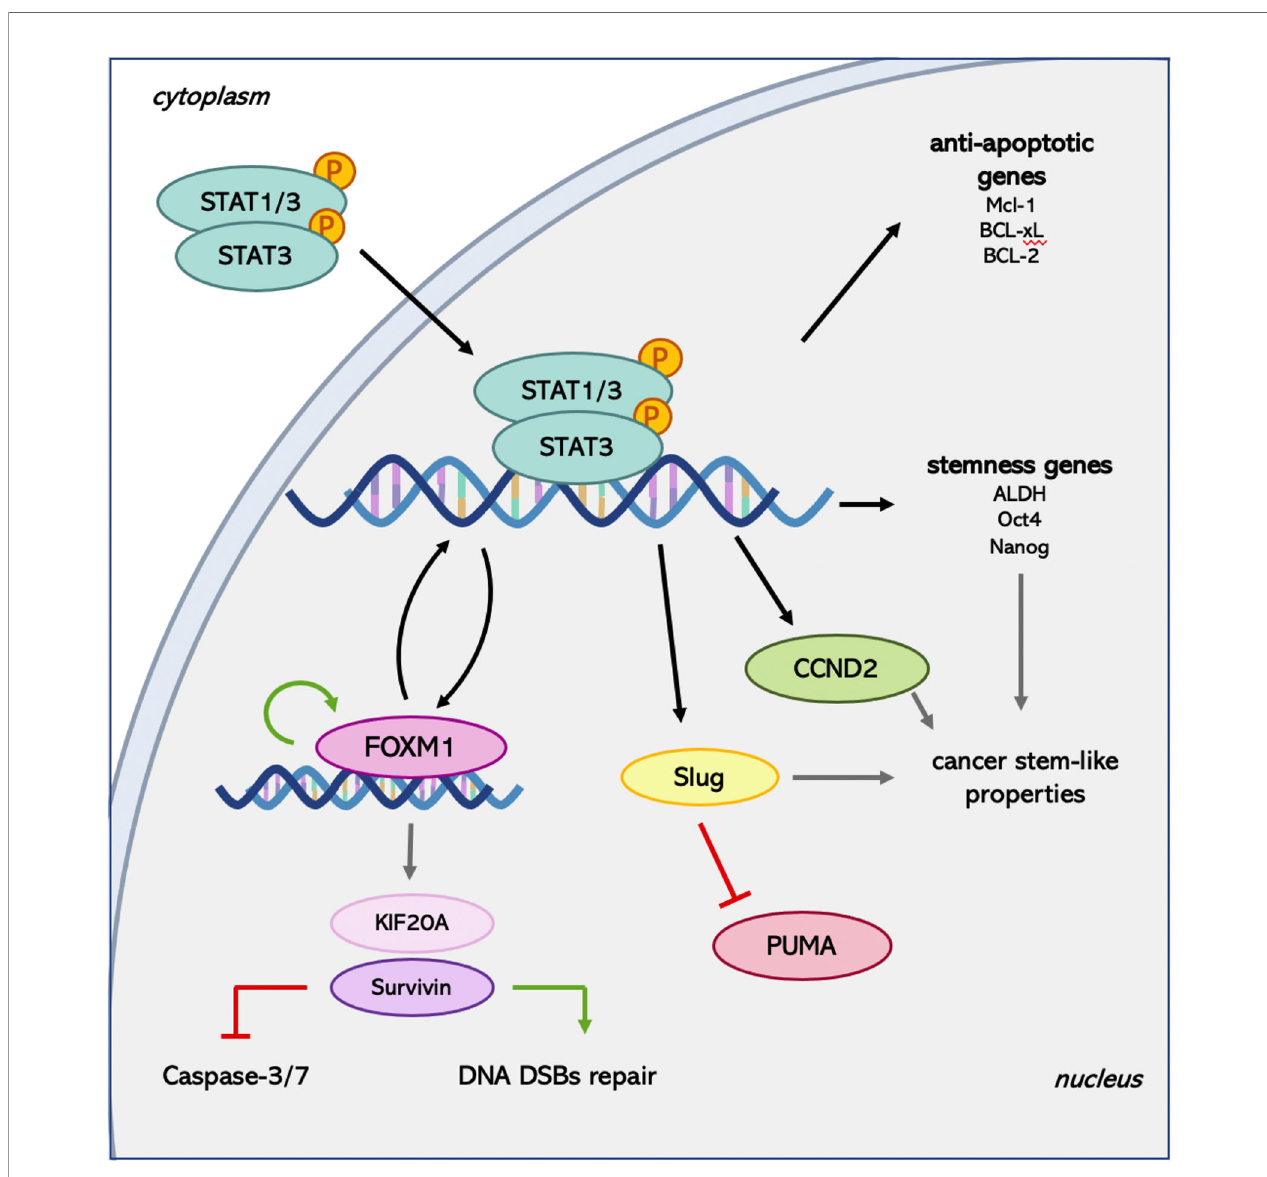
FIGURE 2 | Summary of the main pathways activated by STAT3 following radiation treatment. FOXM1 is known to be able to regulate its own expression (91) and STAT3 transcription (92) establishing a positive feedback loop. Moreover, it induces Survivin expression, which can exert both Caspase-dependent and -independent downstream effects. Finally, STAT3 mediates the activation of genes involved in the maintenance of the CSCs pool, providing another system to promote